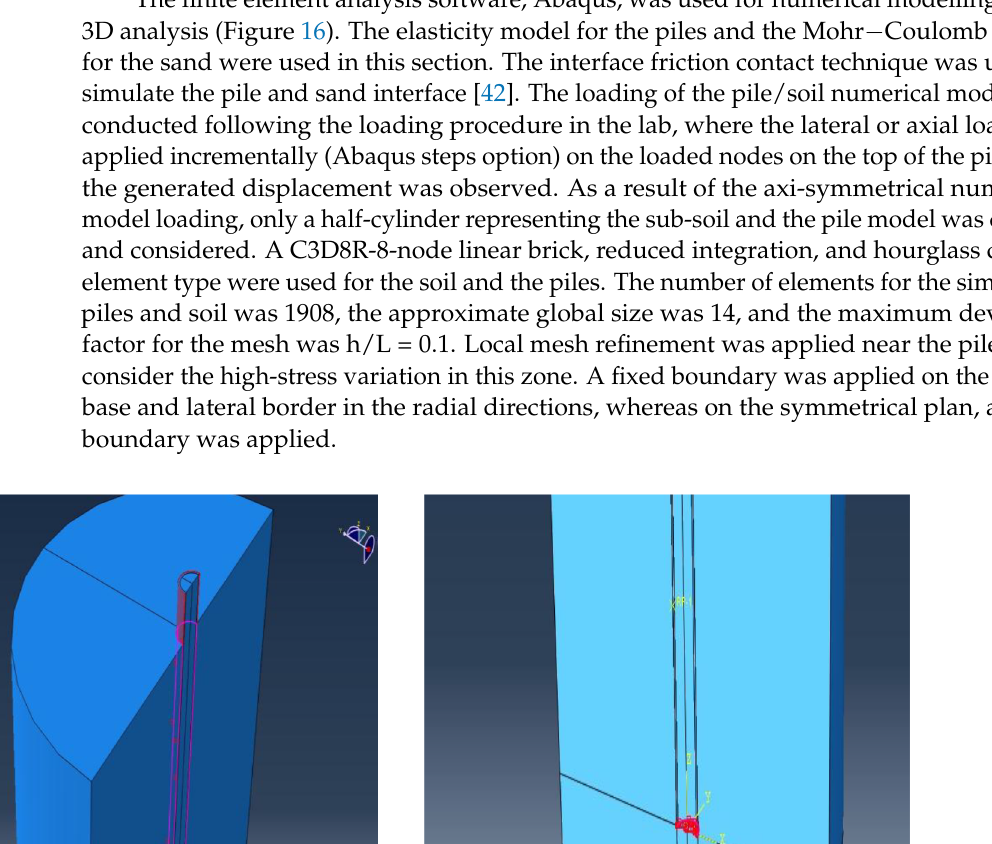
Table 5. Materials used in the numerical modelling.